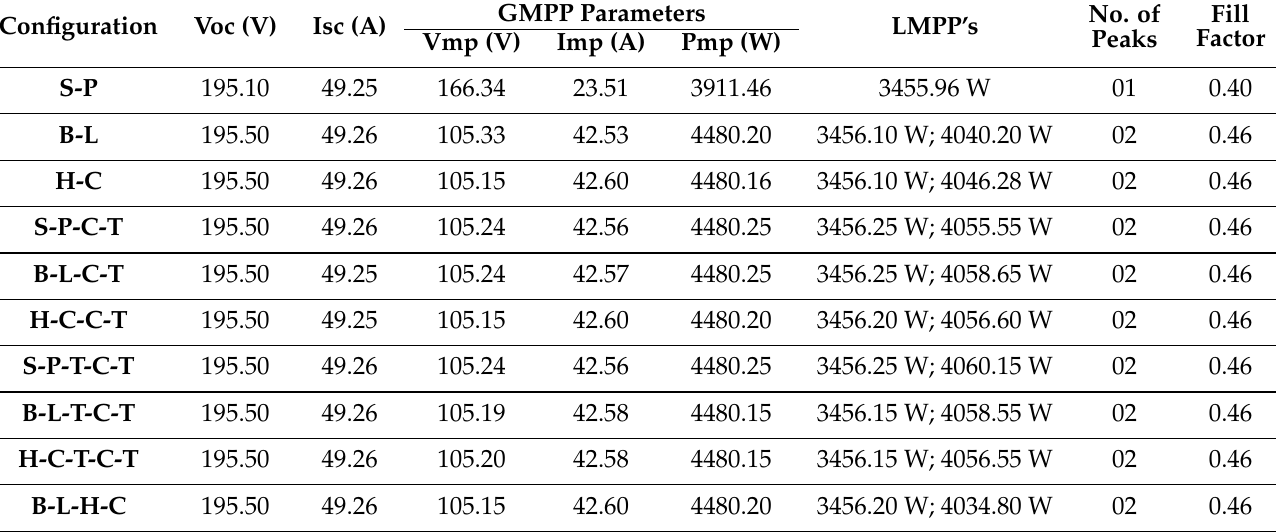
Table 6. Parameter variations of conventional and hybrid configurations under SAW